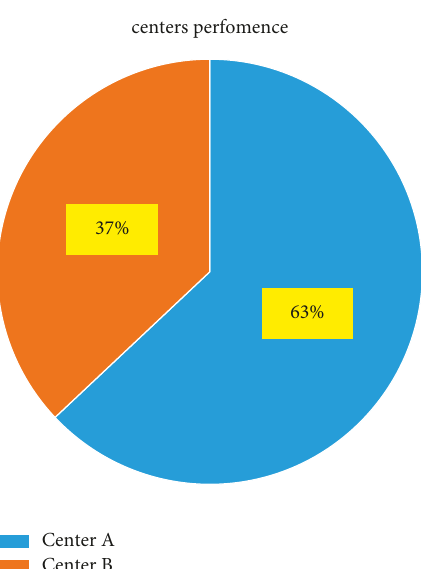
Figure 4: PROMETHEE output.